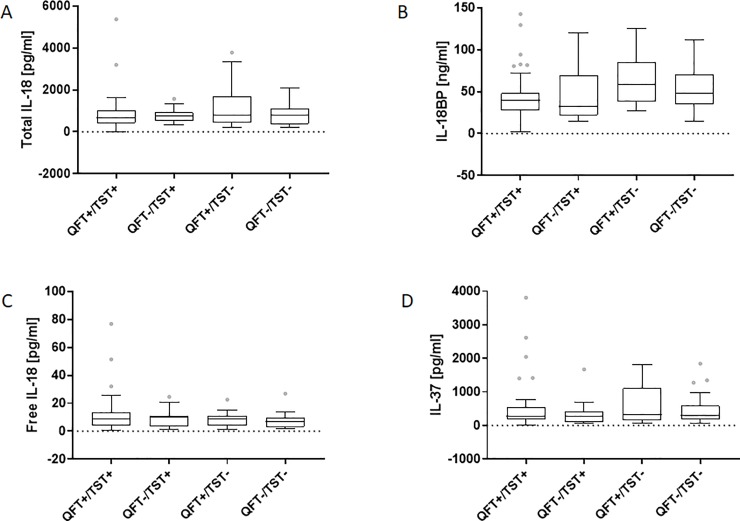
Levels of total IL-18, IL-18BP, free IL-18 and IL-37 in M.tb antigens-stimulated QuantiFERON (QFT) supernatants versus QFT/TST result.Boxplots with median (horizontal line within the box), interquartile range (box limits), and extremes (whiskers) of levels of total IL-18 (A), IL-18BP (B), free IL-18 (C), IL-37 (D) in M.tb antigens-stimulated QFT supernatants from active tuberculosis patients with positive or negative QuantiFERON (QFT) and tuberculin skin test (TST) results.